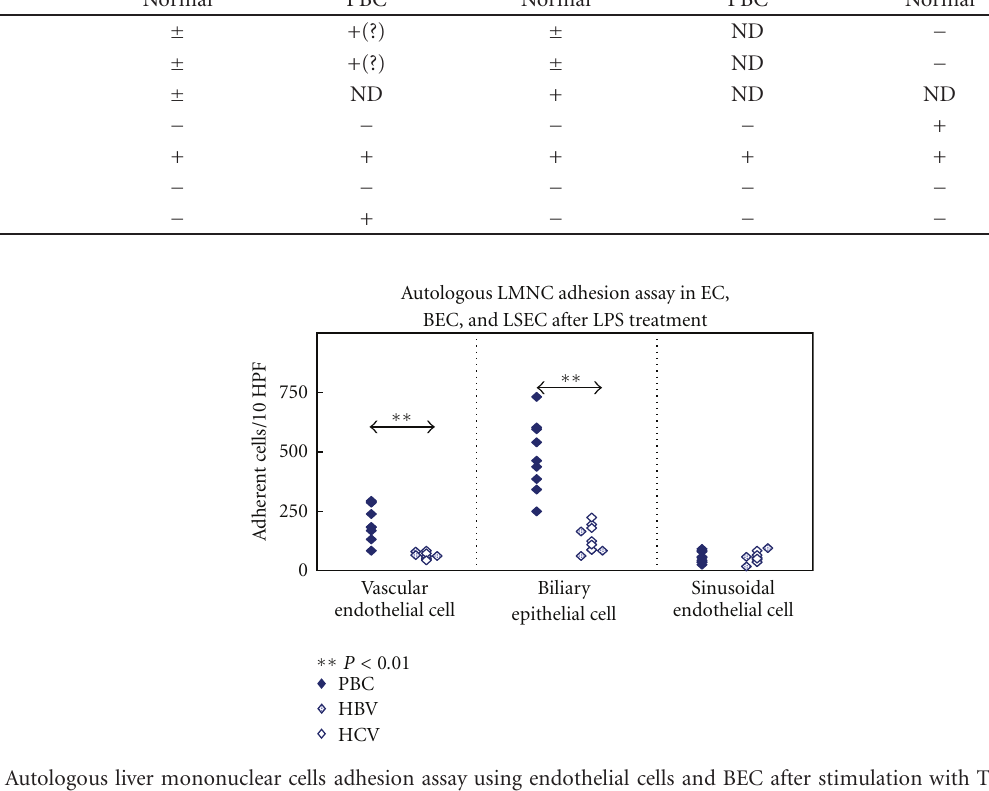
key proinflammatory cytokine in acute rejection [16].